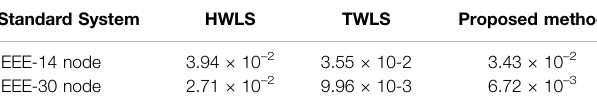
TABLE2| AverageabsoluteerrorofvoltagephaseangleunderGaussiannoise( ° ).